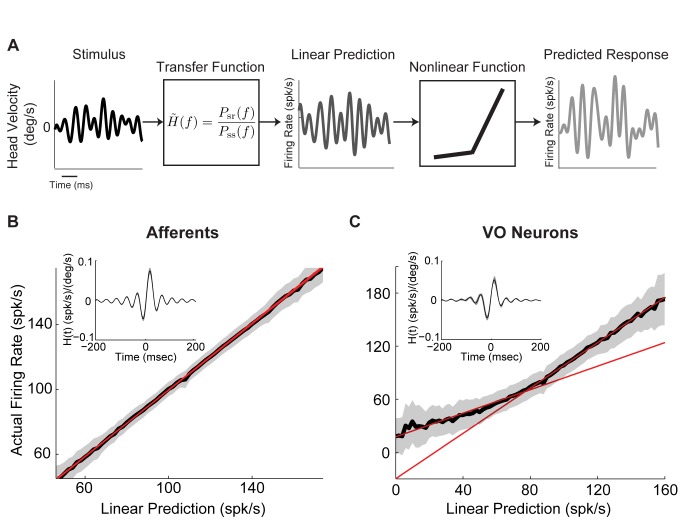
A linear-nonlinear (LN) cascade model reveals that central vestibular neurons respond nonlinearly to broadband noise stimulation.(A) Schematic showing the LN model's assumptions. The stimulus (left) is convolved with a filter H(t) that is given by the inverse Fourier transform of the transfer function  in order to generate the linear predicted firing rate (middle). This linear prediction is then passed through a static function f (which can be linear or nonlinear) to give rise to the predicted output firing rate (right). (B) Population-averaged function f for afferents. Also shown is the best-fit line (R
2 = 0.998±0.001, n = 15) (red) whose slope did not significantly differ from unity (p = 0.99, n = 15, pairwise t test). Inset: population-averaged filter H(t) for afferents. (C) Population-averaged function f for central VO neurons. Also shown are the best-fit straight lines for the intervals (0–80 Hz) and (80–160 Hz) (red) whose slopes were significantly different from one another (p = 0.0014, n = 13, pairwise t test). Inset: population-averaged filter H(t) for central VO neurons.